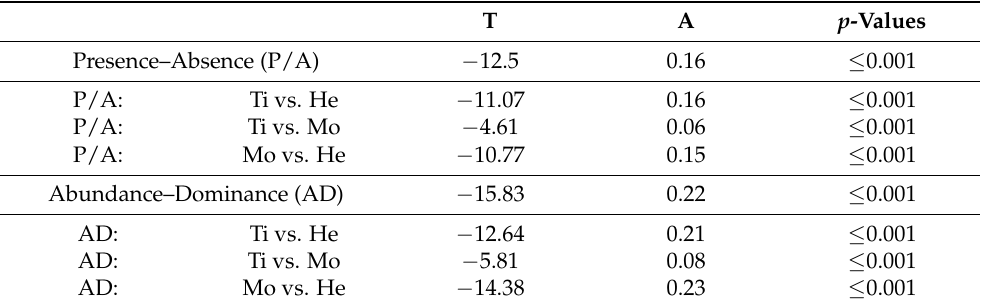
Table 1. Results from multi-response permutation procedure (MRPP) tests of no differences among weed communities—run on both presence/absence (P/A) and abundance–dominance (AD) data— and pairwise comparisons between soil tillage (Ti), mowing (Mo), and chemical herbicides (He).